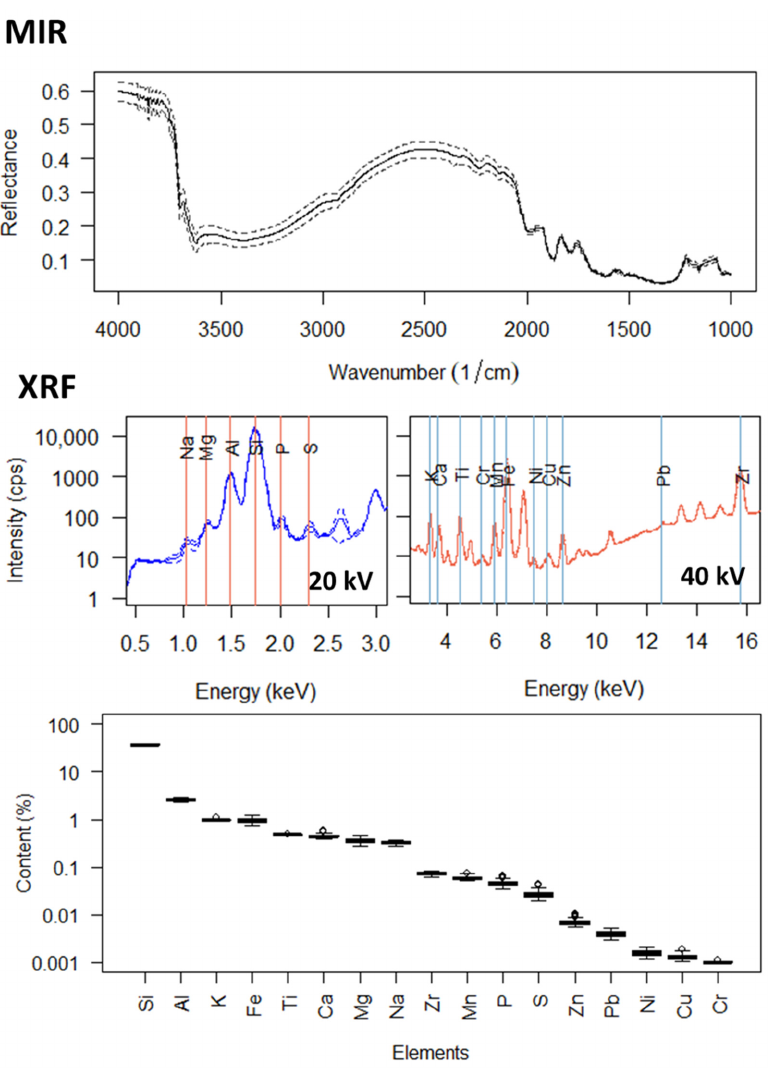
Figure 1. Average (solid lines) ± 2 standard deviations (dotted lines) mid-infrared (MIR) and X-ray fluorescence (XRF) spectra for n = 117 soils, as well as boxplots of the total elemental contents estimated by XRF. K α 1 lines for each element are shown, besides for Pb, which utilized the L β 1 line. The y-axes of the XRF spectra and elemental contents have logarithmic scales.